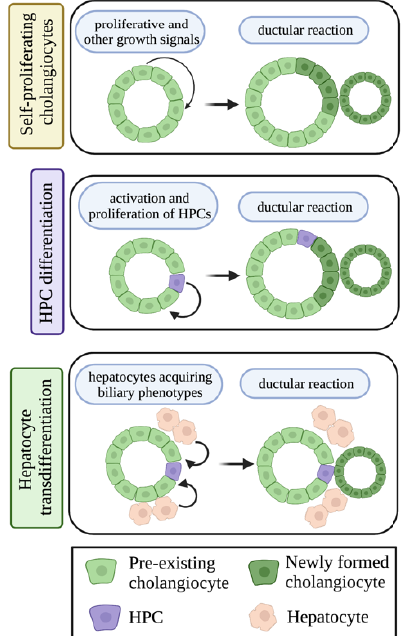
Figure 2. Different cellular compartments can contribute to ductular reaction. Pre-existing cholangiocytes can undergo self-proliferation to generate ductular reactive cholangiocytes; HPCs can become activated, proliferate, and differentiate to a cholangiocyte, thus contributing to ductular reaction; and hepatocytes can acquire biliary phenotypes and undergo transdifferentiation to a cholangiocyte-like cell type and generate ductular reaction. Image made with BioRender (https://biorender.com/).